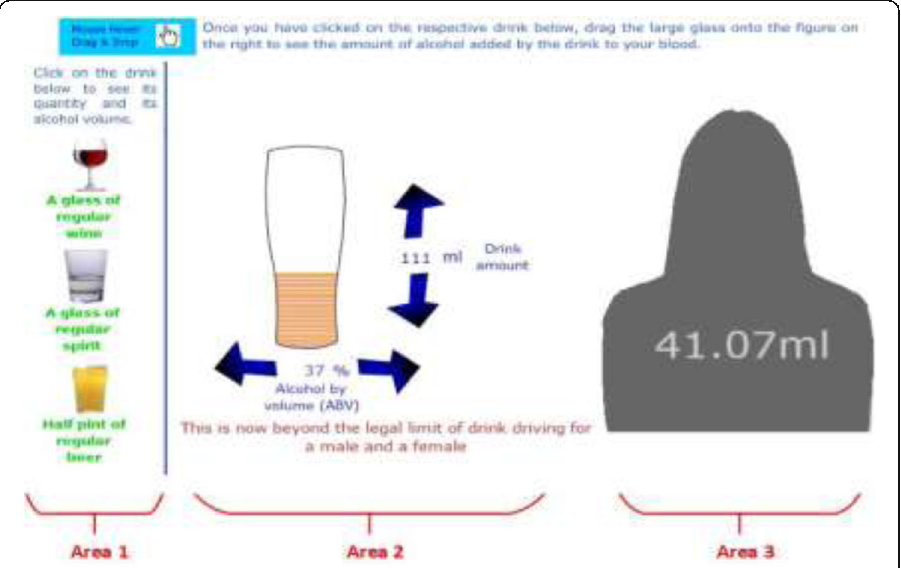
Fig. 4 Example of using a combination of interactive techniques: Click on ROI, using arrows, and drag and drop, taken from Substance Abuse